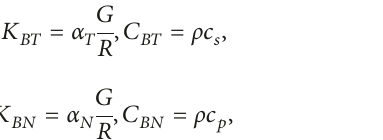
Figure 4: Typical soil profile in the middle of intersection